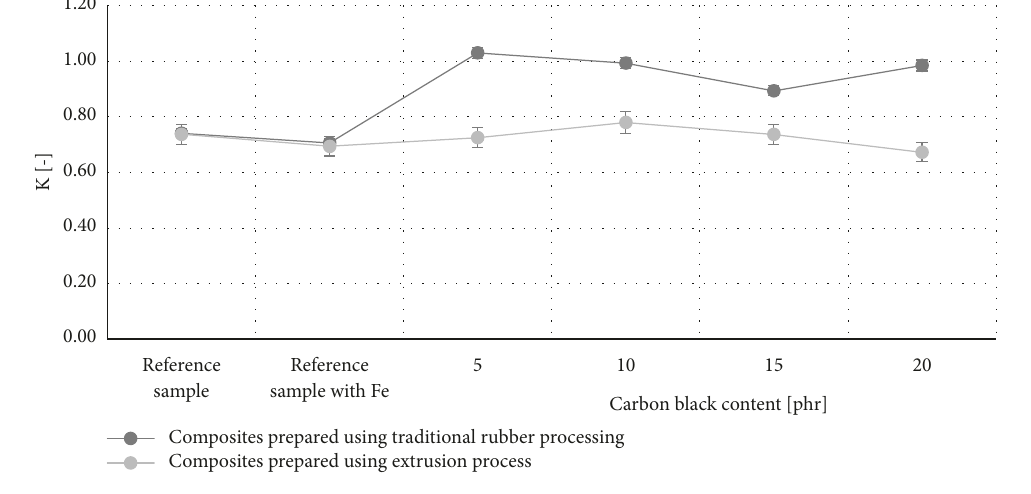
surface of vulcanizates, which initiate the degradation of the elastomeric composites